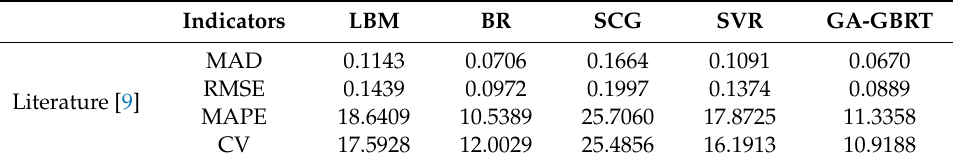
Table 6. Comparison of literature prediction